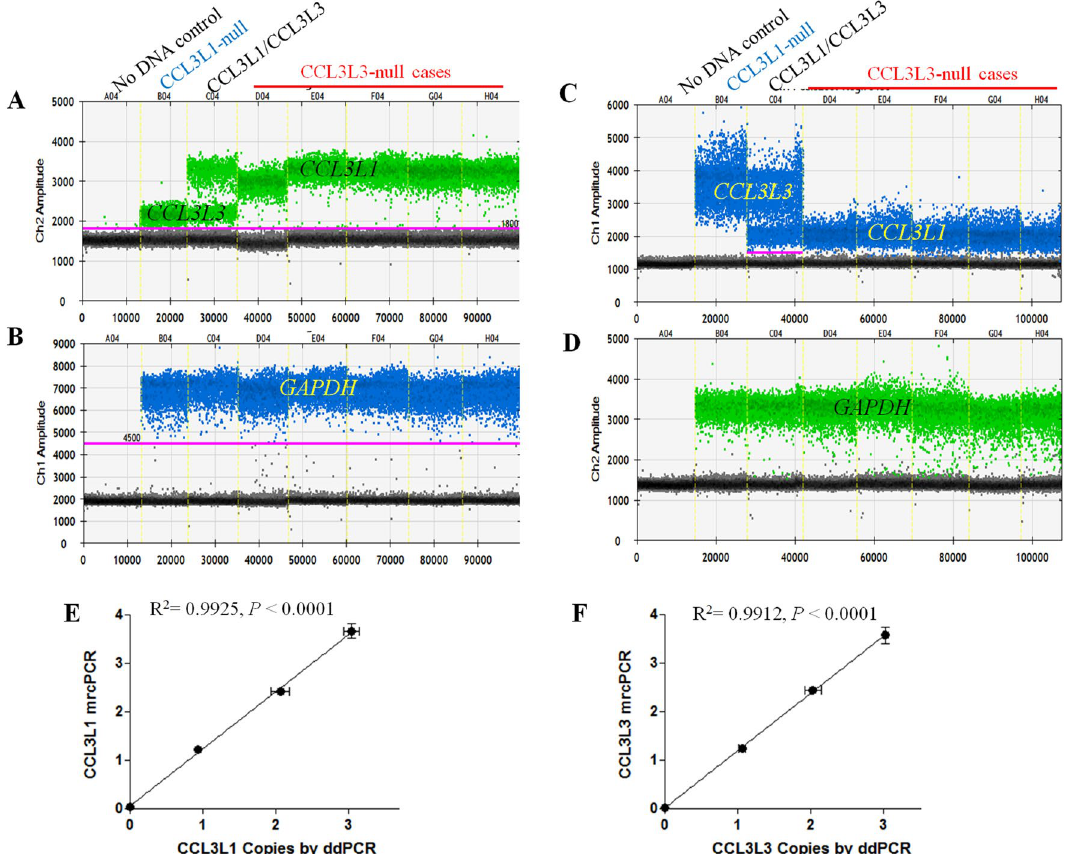
Figure 5. Correlation between mrcPCR and ddPCR results for CCL3L1 and CCL3L3 . ( A ) ddPCR results for CCL3L1 and CCL3L3 using a CCL3L1 -specific probe in a CCL3L1 -null case, five CCL3L3 -null cases, and a case with both alleles. In addition to specific signals from CCL3L1 (marked as CCL3L1 ), weak signals from the CCL3L3 sequence (marked as CCL3L3 ) were also detected. ( B ) ddPCR results for the control GAPDH gene with a probe labeled by fluorescein phosphoramidite (FAM) in assays using a CCL3L1 -specific probe. ( C ) ddPCR results for CCL3L1 and CCL3L3 using a CCL3L3 -specific probe in the same cases as in ( A ). In addition to specific signals from CCL3L3 (marked as CCL3L3 ), weak signals from the CCL3L1 sequence (marked as CCL3L1 ) were also detected. ( D ) ddPCR results for the control GAPDH with a probe labeled by Hexachloro- Fluorescein in assays for the CCL3L3 -specific probe in ( C ). ( E ) Linear correlation between mrcPCR and ddPCR results for CCL3L1 (R 2 = 0.9925, P < 0.0001, N = 16). ( F ) Linear correlation between mrcPCR and ddPCR results for CCL3L3 (R 2 = 0.9912, P < 0.0001, N = 16). For ( E ) and ( F ), three cases for each dCN (0–4) by mrcPCR assay were analyzed. Figures ( A ) to ( D ) for ddPCR results were obtained from QuantaSoft analysis software version 1.74 (BioRad